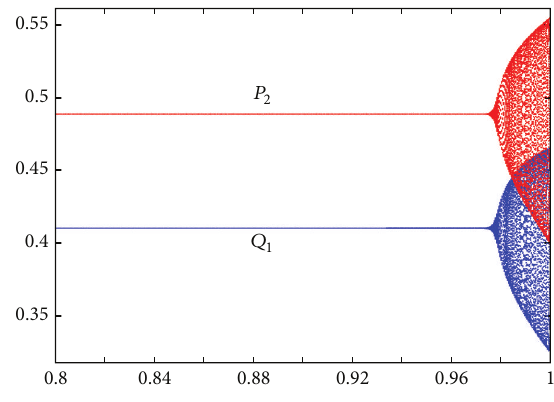
Figure 14: Bifurcation diagrams of system (11) for 𝛼 = 2.5 , 𝛽 = 2.3 and 𝜔 1 = 𝜔 2 = 𝜔 varying from 0.8 to 1